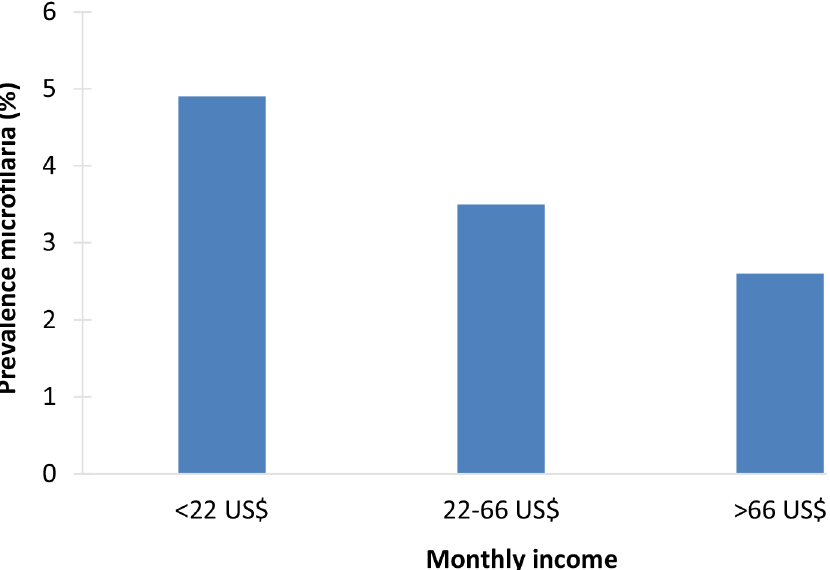
Fig 4. Example of socioeconomic inequalities in LF: association between microfilaria prevalence (%) and household monthly income (US$) in Karimnagar district, India (2004 – 2007) [20]. The study was performed in Karimnagar district (Andhra Pradesh, India), which is a filariasis-endemic region where a mass drug administration (MDA) program has been active since 2004. Blood samples were taken from 5,394 inhabitants of all ages from 30 villages and tested for Wuchereria bancrofti microfilaria. Socioeconomic information was collected through an interview with the household head or other family members. Household monthly income was divided into three categories ( < US$22; US$22 – US$66; > US$66; currency rate used: 1 Indian Rupee = US$0.022, January 2006). In total, 3.7% of the blood samples tested positive for microfilaria. Microfilaria prevalence was statistically significantly ( p = 0.02) associated with household income, with the poorer households being more affected than the richer